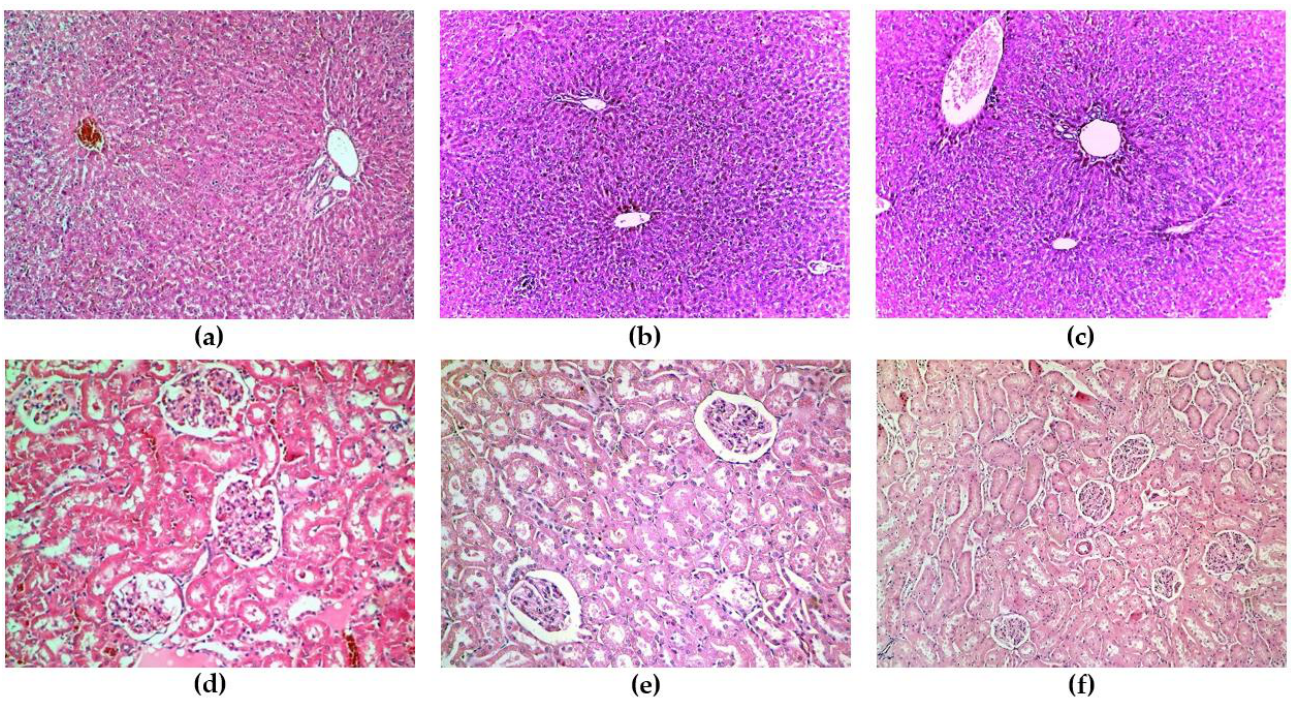
Figure 2. Histological examination: ( a ) liver—dose of 50 mg/kg b.w. ( b ) liver—dose of 300 mg/kg b.w., ( c ) liver—dose of 2000 mg/kg b.w., ( d ) kidney—dose of 50 mg/kg I., ( e ) kidney—dose of 300 mg/kg b.w. and ( f ) kidney—dose of 2000 mg/kg